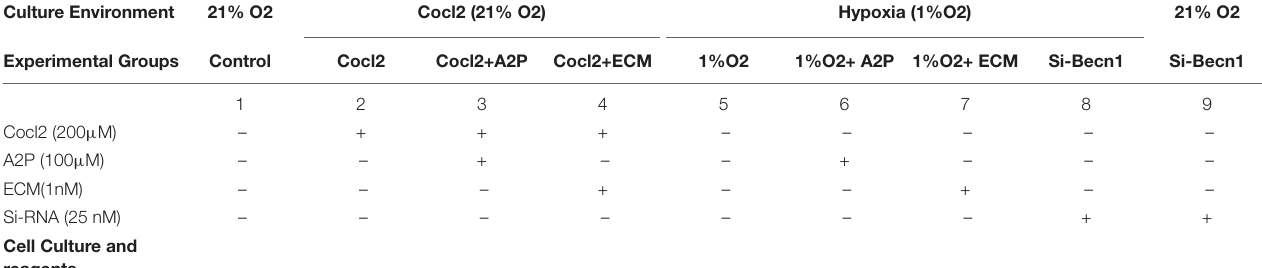
TABLE 1 | Experimental groups and cell culture environment. Culture